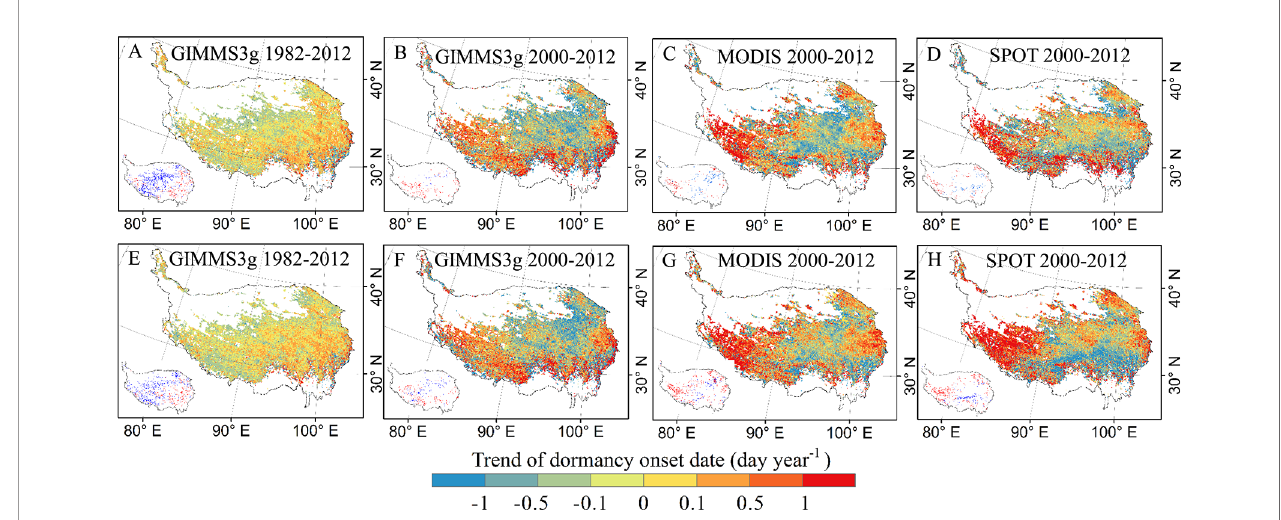
FIGURE 3 | Spatial patterns of trends in the vegetation DOD based on GIMMS3g, SPOT, and MODIS NDVI data sets determined by threshold method (A – D) and derivative method (E – H) . Pixels with signi fi cantly (P < 0.05) positive (red) and negative (blue) trends are shown in the left bottom of each submap.